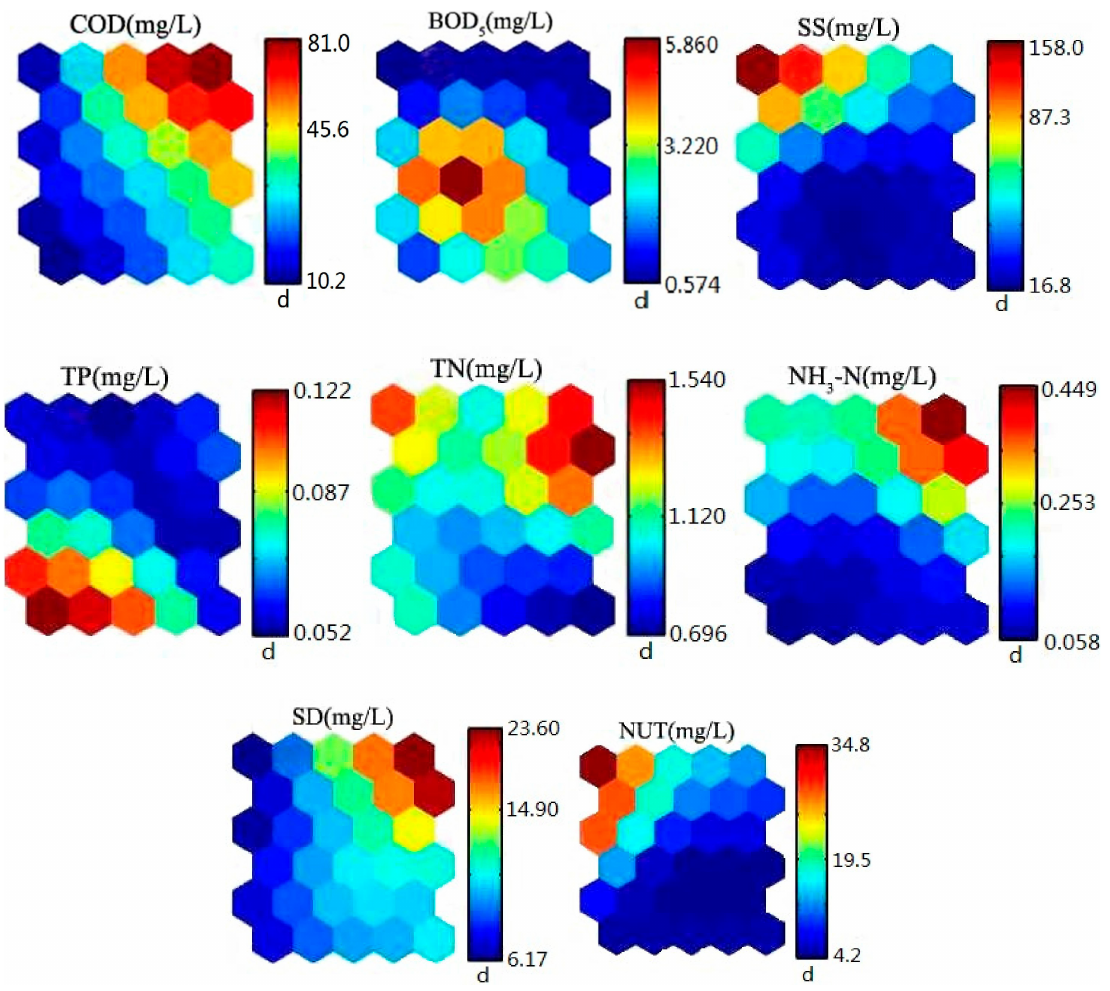
Figure 4. The patterning results for the water quality parameters on the SOM